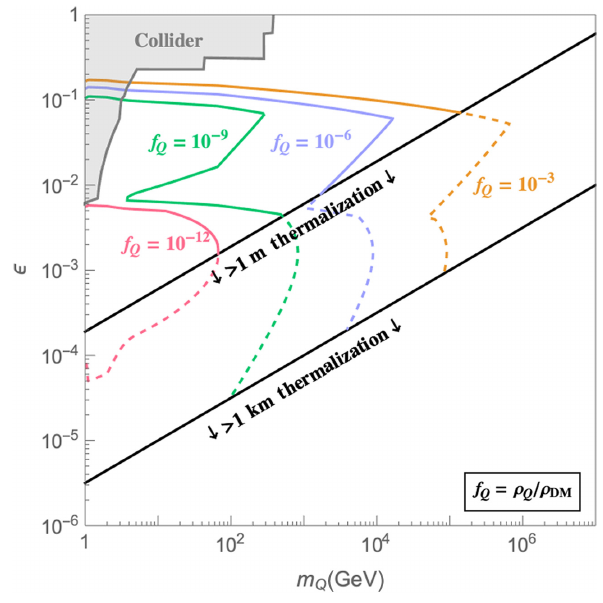
FIG. 4. The limits and projections (95% CL) on the virial DM fraction in mCPs as a function of (cid:2) and m Q . Since the current experiments are all conducted at the surface, the robust limits are only above the “ > 1 m thermalization” line, where the colored contours are solid. For a hypothetical deep-mine experiment, the dashed part of the contours is also